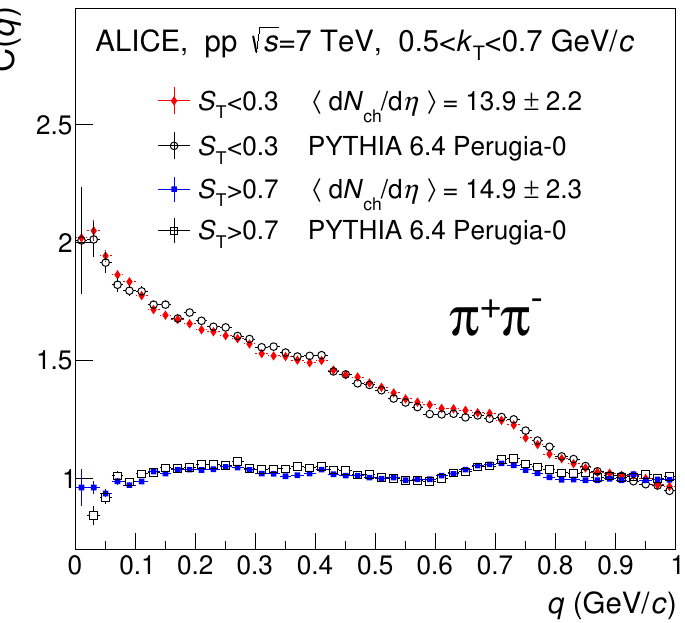
Figure 1 . Opposite-sign pion pair correlation functions in data and PYTHIA simulations for high and low sphericity intervals. The error bars represent statistical